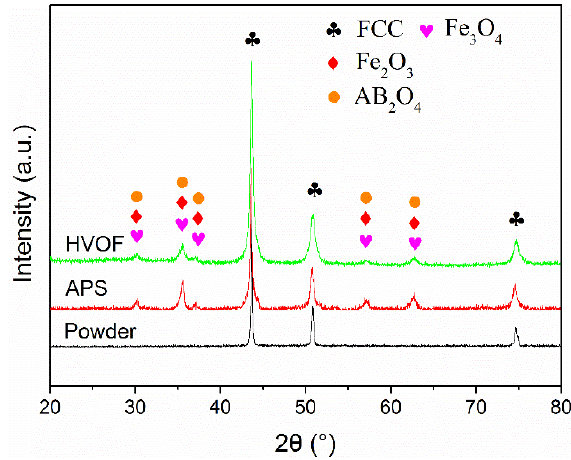
Figure 2. X-ray diffraction (XRD) pattern of the FeCoCrNiMo0.2 gas-atomized powders and the HEA coatings: oxides consist of a mixture of Fe 3 O 4 , Fe 2 O 3 , and some binary oxides with the chemical formula of AB 2 O 4 (A = Fe, Co, Ni and B = Fe, Cr).